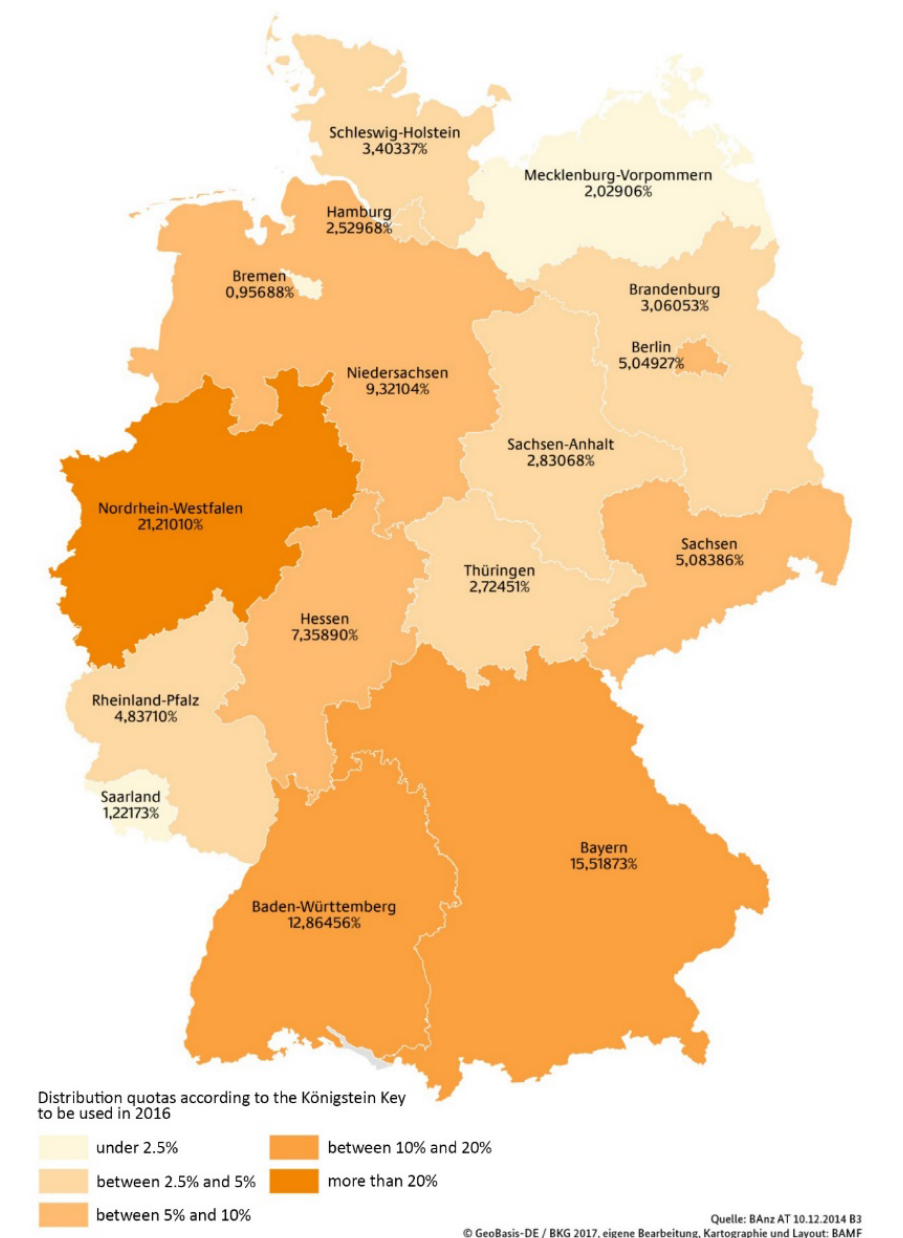
Figure 1. Refugee distribution quotas, in German federal states, according to the Königstein key in 2016. Source: translated from BAMF (2017, p.